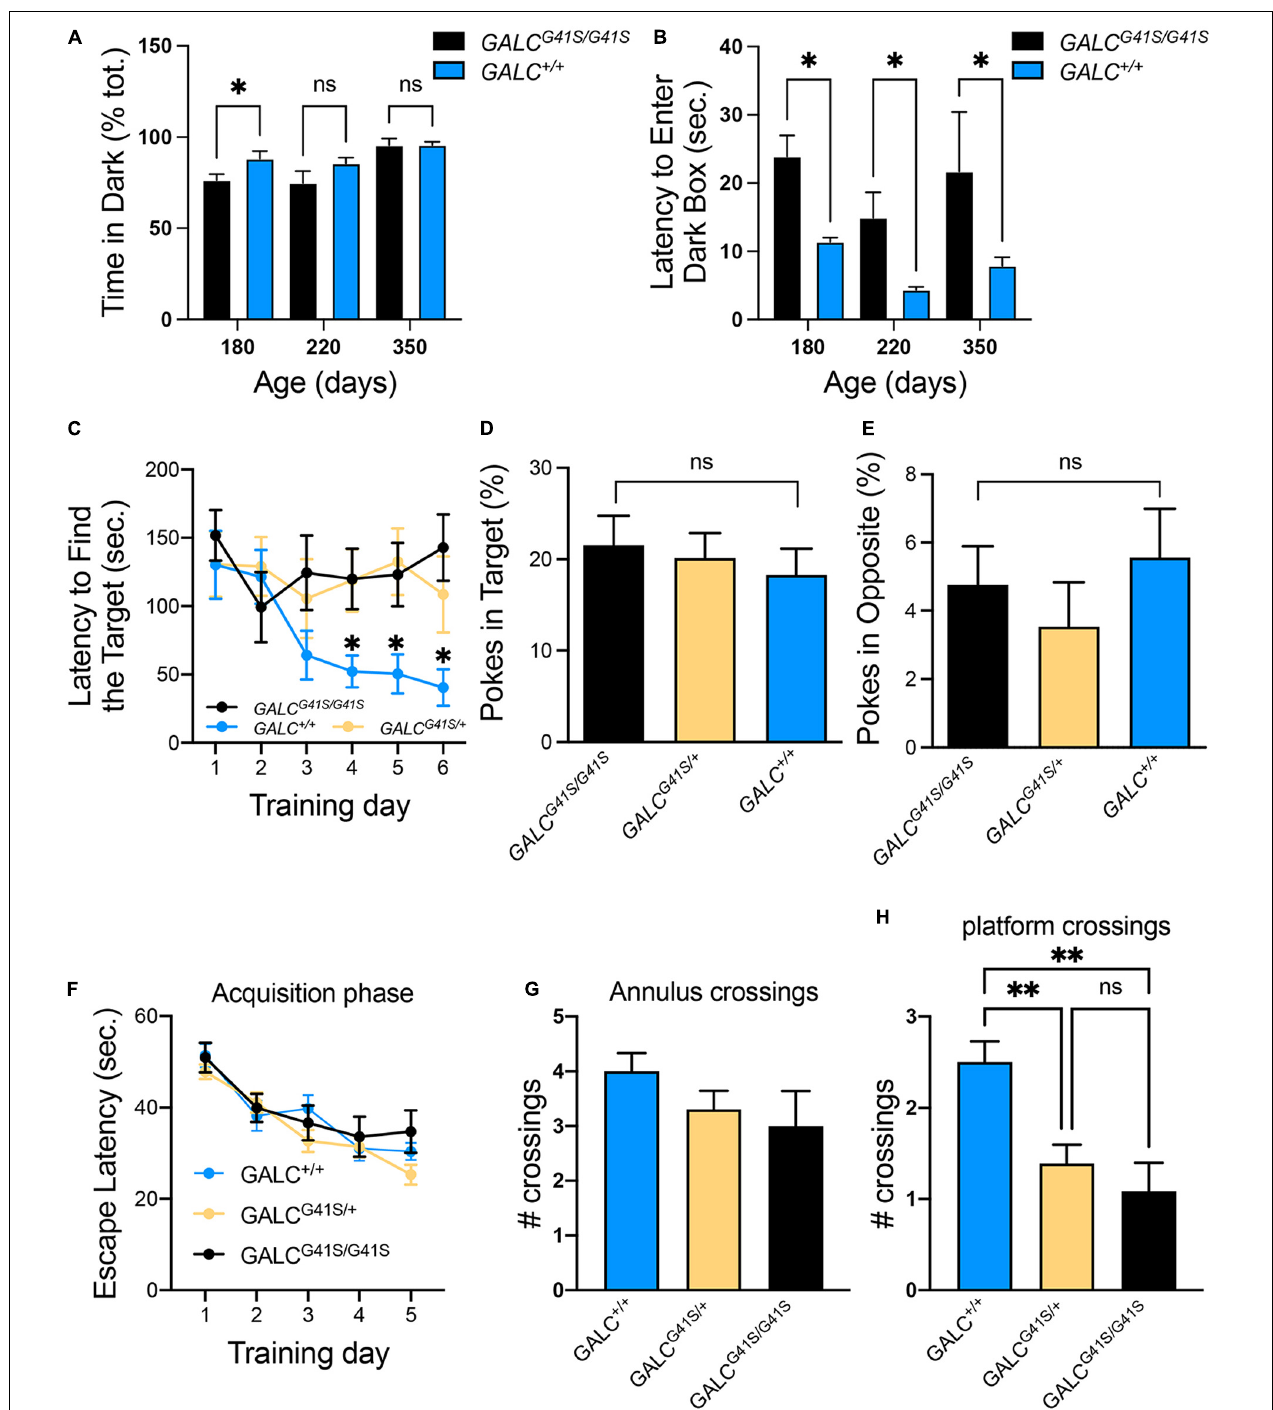
FIGURE 6 | Cognitive capacity and spatial learning performance are slightly impaired in GALC G 41 S / G 41 S mice. (A,B) Activity of GALC G 41 S / G 41 S mice in the dark-light box showed slightly less time spent exploring the dark compartment in younger (P180) vs aged older (P220, P350), with an increased latency to enter in the dark box at all time points. Data represent the mean + SEM of n = 4–6/group, analyzed by ANOVA/Tukey’s post hoc test ∗ p < 0.05. (C–E) The Barnes maze test showed GALC G 41 S / G 41 S and GALC G 41 S / + mice increased times to identify the target hole (C) , with no significant differences in the percentage of pokes in target (D) vs opposite (E) holes. Data represent the mean + SEM of n = 6/group, analyzed by ANOVA/Tukey’s post hoc test ∗ p < 0.05. (F–H) The Morris water maze test measured no significant differences in the escape latency (F) and annulus crossings (G) but significant decreases in the number of platform crossings in both GALC G 41 S / G 41 S and GALC G 41 S / + mice. Data represent the mean + SEM of n = 6–8/group, analyzed by ANOVA/Tukey’s post hoc test ∗∗ p < 0.01.